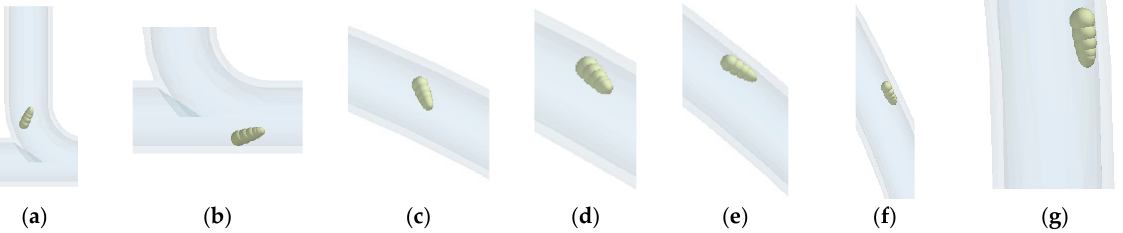
Figure 10. Movement state of cotton seeds at special moments. ( a ) t = 0.49 s; ( b ) t = 0.54 s; ( c ) t = 0.68 s; ( d ) t = 0.69 s; ( e ) t = 0.72 s; ( f ) t = 0.79 s; ( g ) t = 0.84 s.